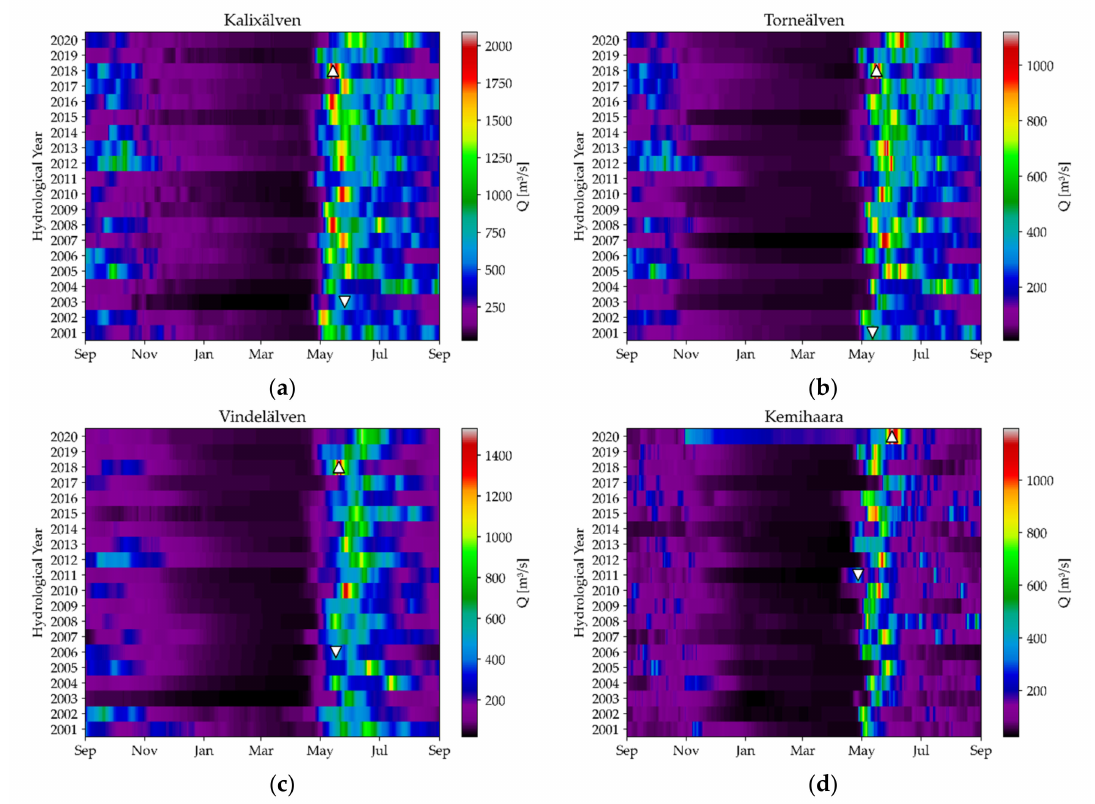
Figure 9. Discharge plots of ( a ) Kalixälven, ( b ) Torneälven, ( c ) Vindelälven, and ( d ) Kemihaara. The upward pointing triangle indicates the maximum spring flood, the downward pointing the